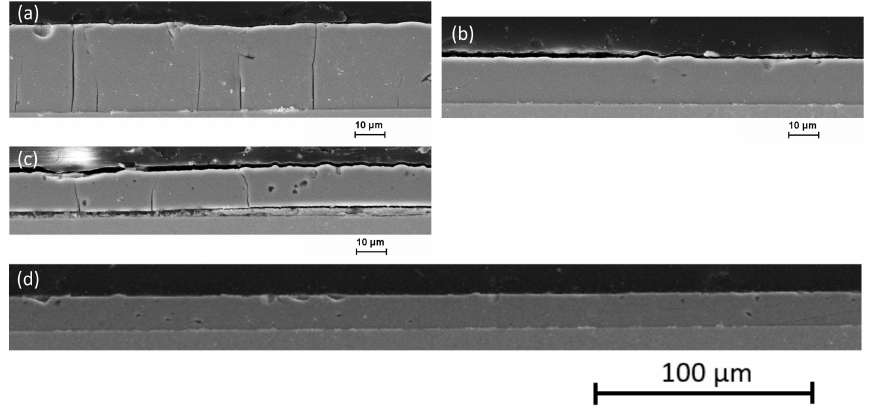
Figure 5. Scanning electron microscopy micrographs of cross-sections of electrodeposited Fe-Cr-Ni coatings under stepped DC conditions for three depositions ( a ) after first 2 h of electrolyte use with microcracks; ( b ) after second 2 h without any microcracks and ( c ) after third 2 h with few microcracks. Picture ( d ) shows a wider range of the Fe-Cr-Ni-layer with deposition parameters from coating ( b